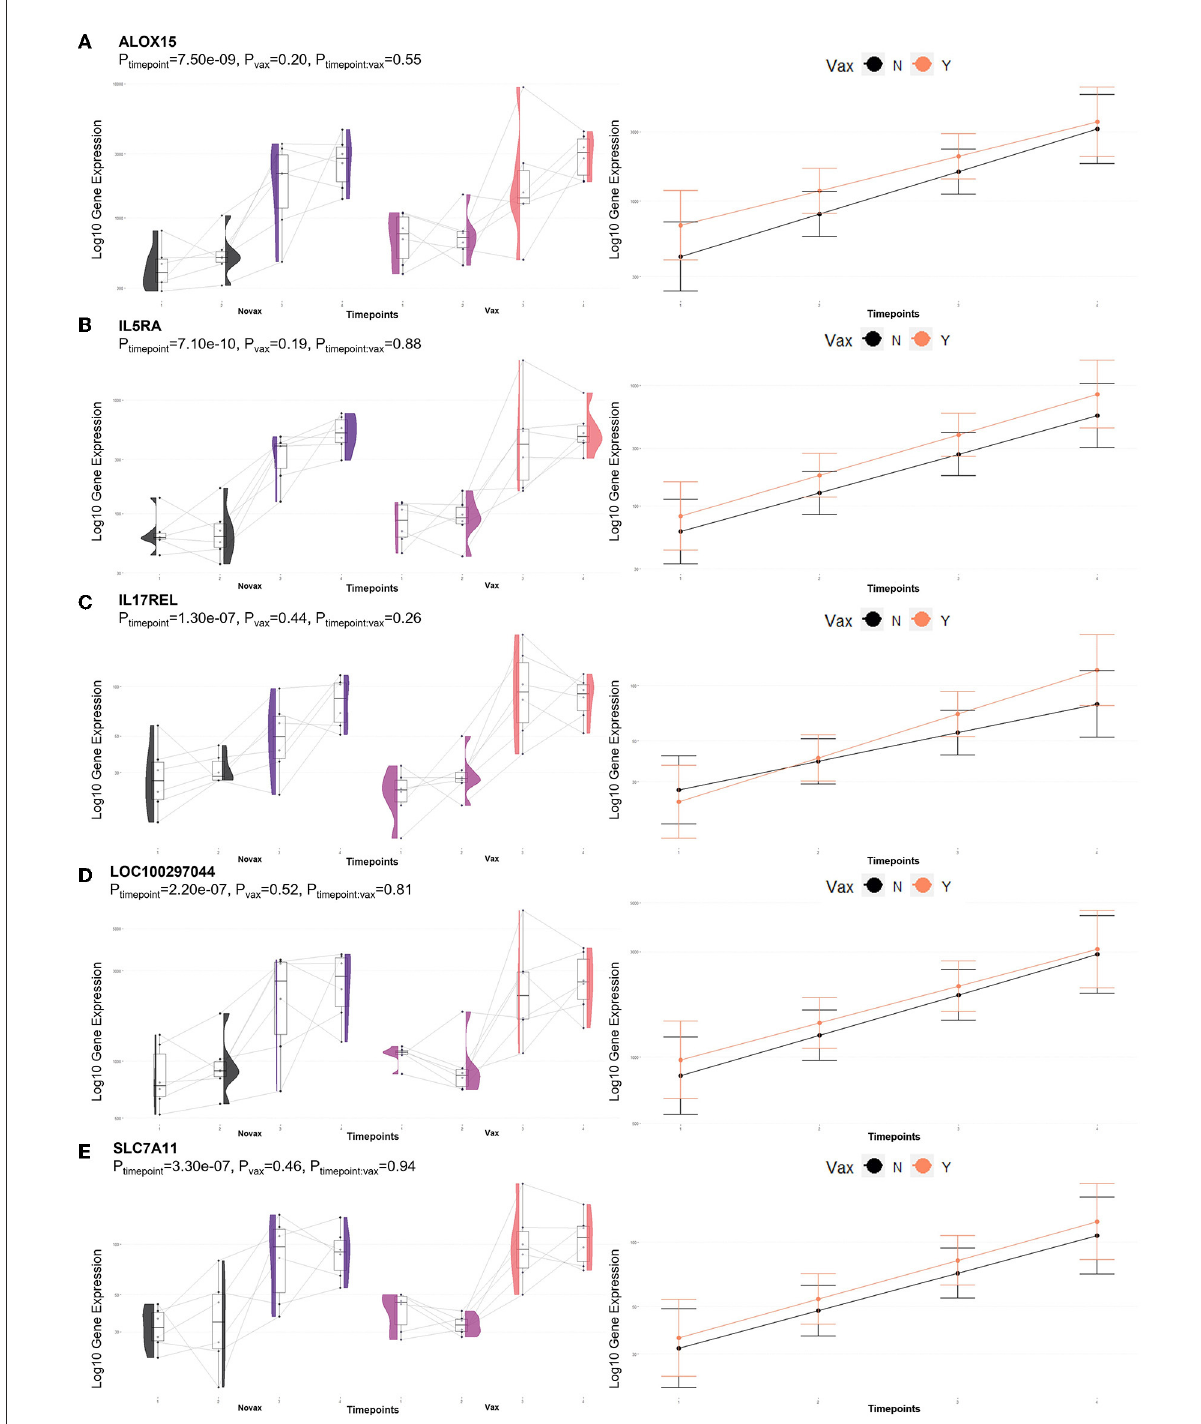
FIGURE5 Gene pairplots and modeled expression trends of key DEGs found in timepoint analyses. Pairplots (left side) demonstrate the log10 normalized gene expression of each sample across all timepoints, overlapped with a violin plot (depicting numerical distributions by density). Box-and-whisker plots represent median expression values (black line), the first (lower) and third quartiles (boxplot limits), 1.5 times the interquartile ranges (whiskers), and outlier expression levels for each timepoint (points outside whiskers). Modeled expression trends (right side) depict the overall differences between groups over each timepoint. Points represent the mean log10 normalized expression value for each group within a timepoint, and bars represent the standard error of log10 normalized expression for each group; orange represents the vaccinated group and black represents the non-vaccinated group. These plots depict the relative expression and glmmSeq level of significance for (A) ALOX15 , (B) IL5RA , (C) IL17REL , (D) LOC100297044 ( CCL14 ), and (E) SLC7A11